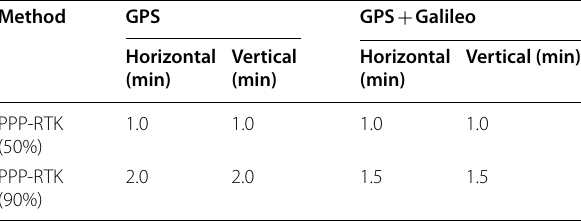
Table 3 Convergence time of PPP-RTK user components for the small-scale network at the 50% and 90% confidence